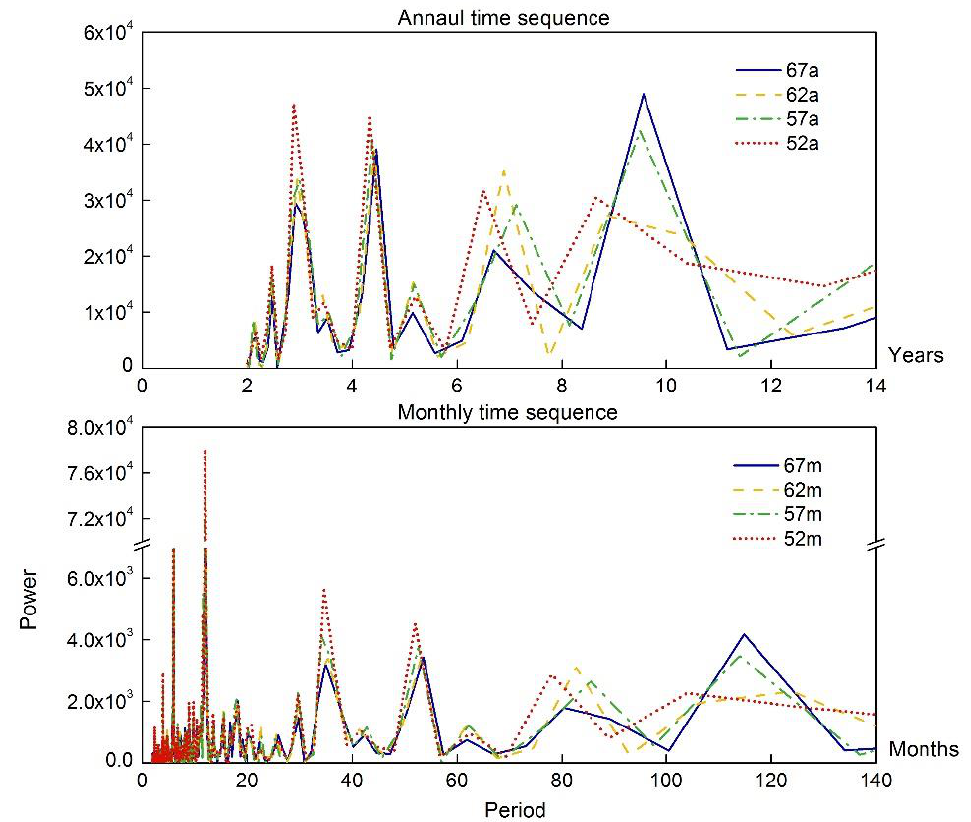
Figure 2. Periodogram of HHS.